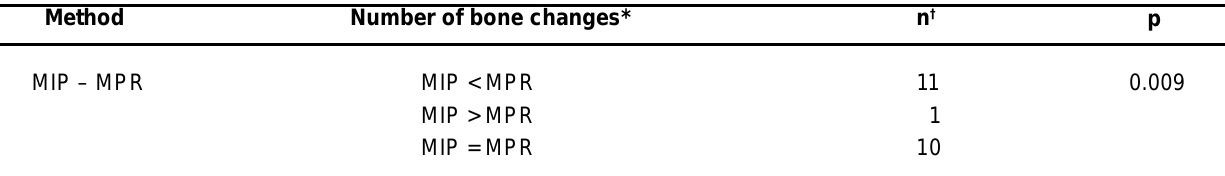
TABLE 2 - Relationship between the number of bone changes diagnosed with MPR and 3DR-MIP, considering each patient individually